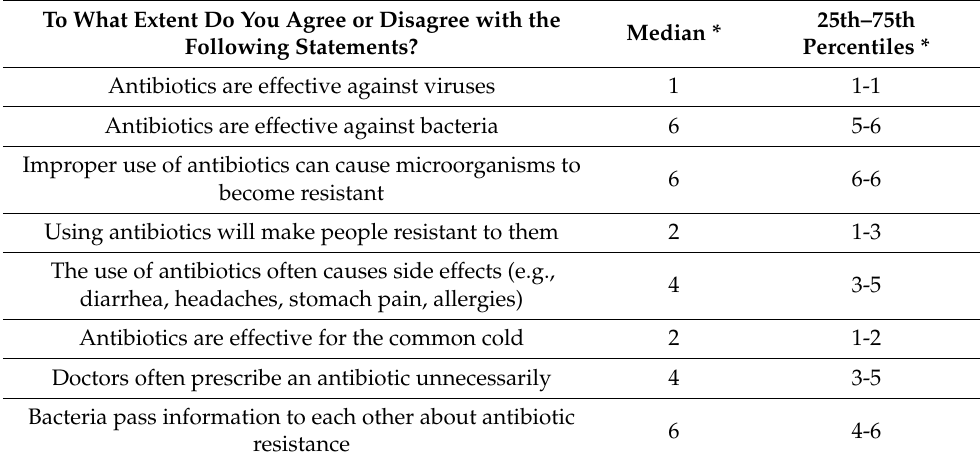
Table 5. Practical knowledge of antibiotics ( n =